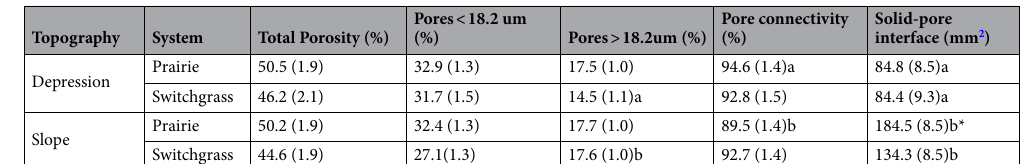
Table 2. Summary of soil pore characteristics for the studied prairie and monoculture switchgrass systems at the two topographical positions before the plant growth experiment. Shown are means (n = 6) and standard errors (in parentheses) for each system and topographical position. Stars (*) indicate significant differences between the cropping systems within each topographical position (p < 0.05) and letters indicate significant differences between the topographical positions within each cropping system (p < 0.05). No stars or letters are shown when the differences were not statistically significant.